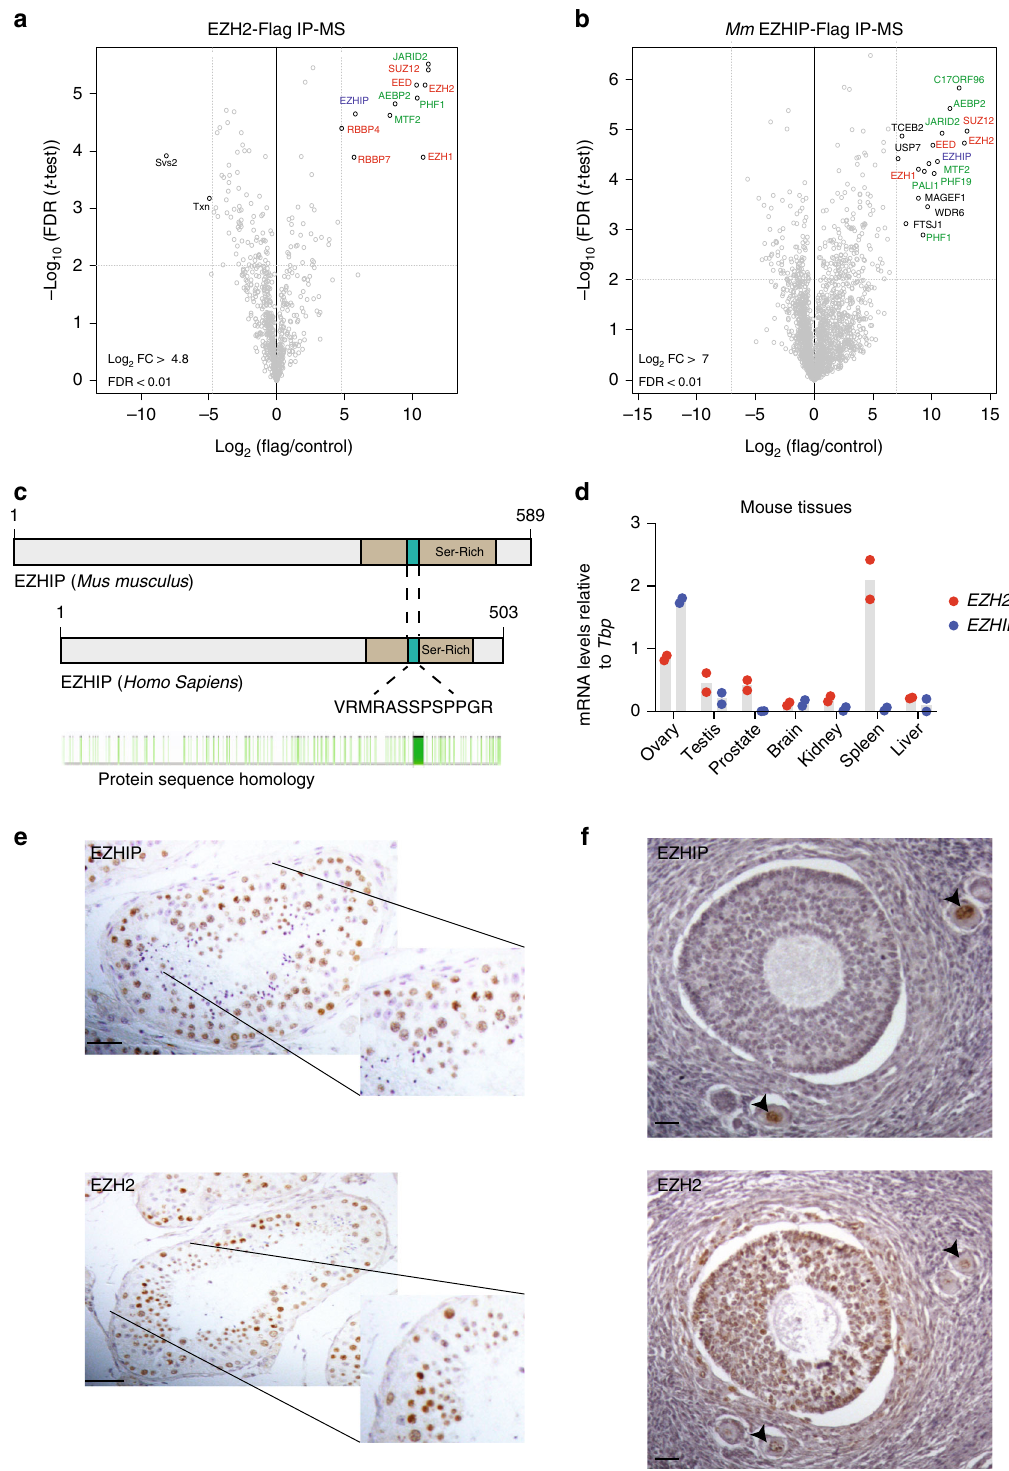
Fig. 1 EZHIP interacts with PRC2 in gonads. a Volcano plot of EZH2 interactome from EZH2-Flag mice testis IP compared with WT. Core complex subunits are in red, in green the cofactors and in blue EZHIP, n = 3. b Volcano plot representation of EZHIP interactome after Flag-IP from HeLa-S3 overexpressing EZHIP compare with WT. Same color codes as in ( a ), n = 3. c Schematic representation of EZHIP protein sequence from Mus Musculus (upper part) and Homo Sapiens (middle part). Serine-rich region is colored in beige, and conserved amino acid stretch in green. The conserved sequence stretch is displayed as well as protein residues conservation between the two sequences in green (Sequence Homology determined using Genious software). d Ezhip and Ezh2 mRNA relative abundance normalized to Tbp in various mice tissues (mean, n = 2). e EZHIP and EZH2 IHC staining on human adult seminiferous tubules sections. Representative result, n ≥ 5. Scale bars, 50 μ m. f EZHIP and EZH2 IHC staining on human adult ovaries sections, black arrows indicate the follicles. Representative result, n ≥ 5. Scale bars, 30 μ